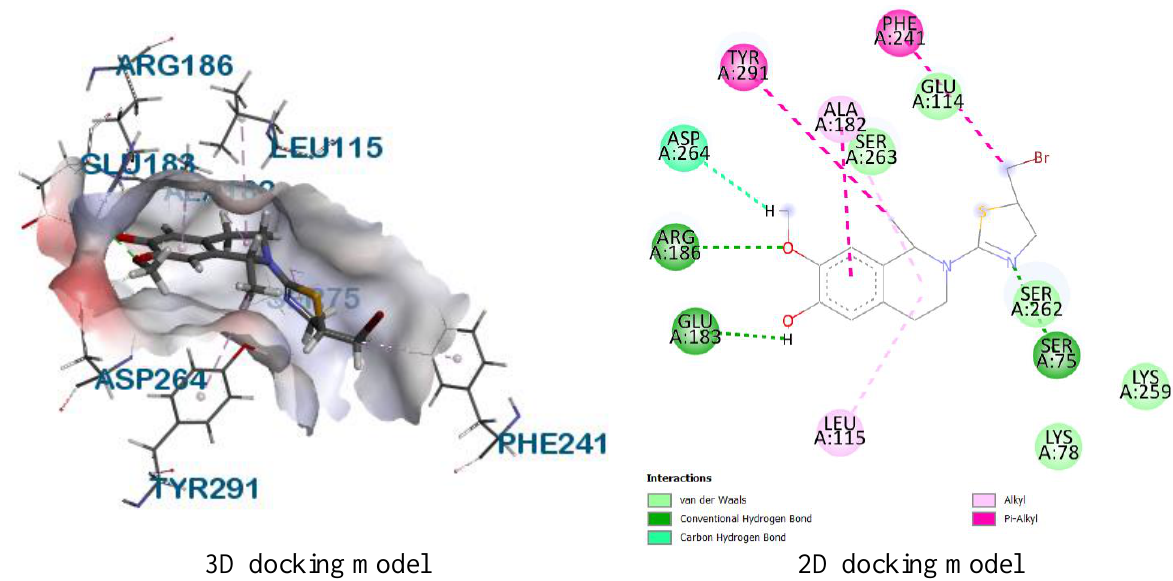
Figure 7. Complex between 12 and Penicillin binding protein 4 S. aureus “Homo sapiens” (3HUN).